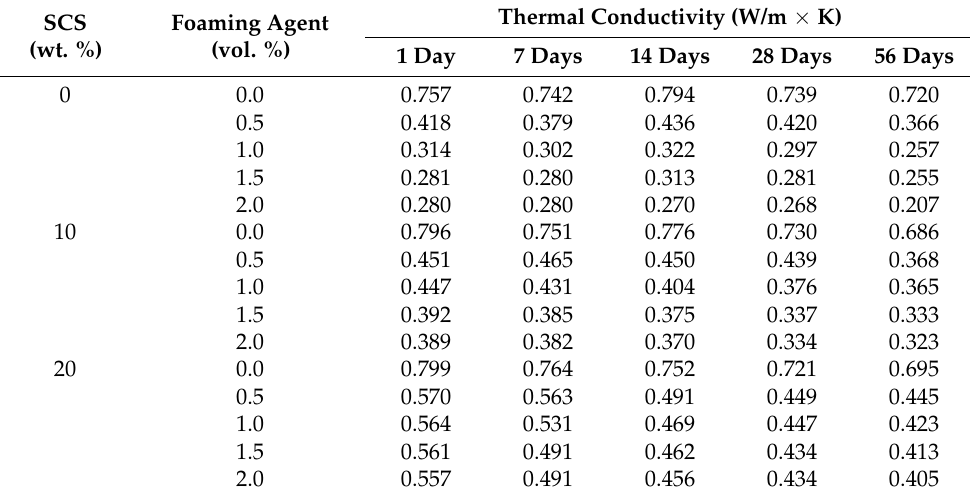
Thermal Conductivity (W/m ×